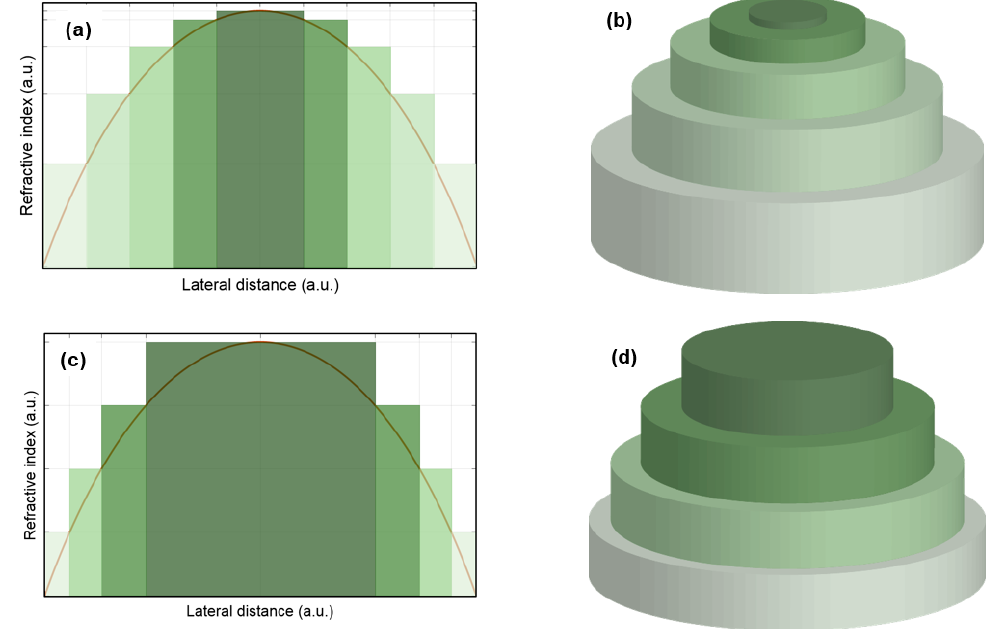
Figure 2. ( a ) Equilateral step (ELS) scheme of the index profile and ( b ) the corresponding surface topology of the device; ( c ) Equi-index step (EIS) scheme and ( d ) the corresponding surface topology of the device.